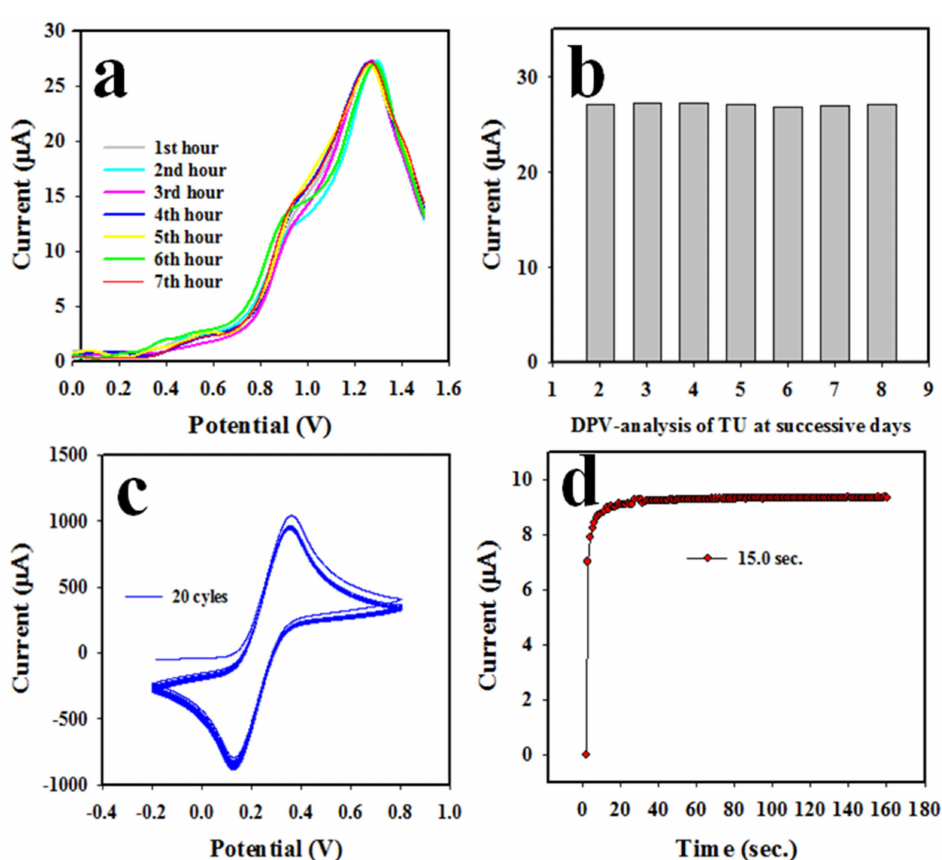
Figure 8. Optimization of sensor probe of Nafion/CuO/ZnO NSs/GCE. ( a ) Reproducibility of TU sensor, ( b ) reproducibility represented in a bar diagram, ( c ) stability of TU sensor and ( d ) response time.